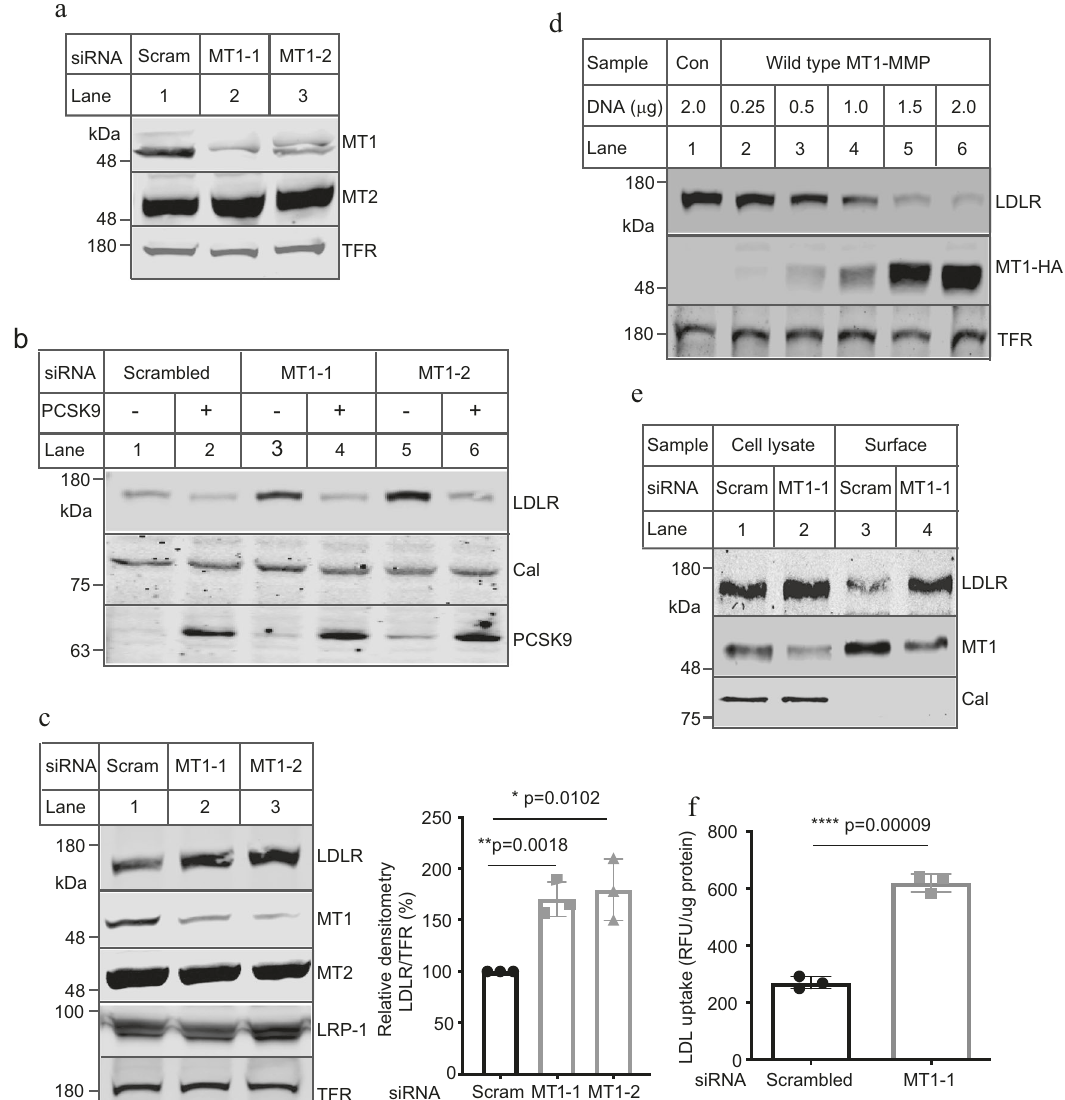
Fig. 1 MT1-MMP-mediated LDLR degradation. a Knockdown of MT1-MMP expression. Whole-cell lysate from Huh7.5 cells transfected with